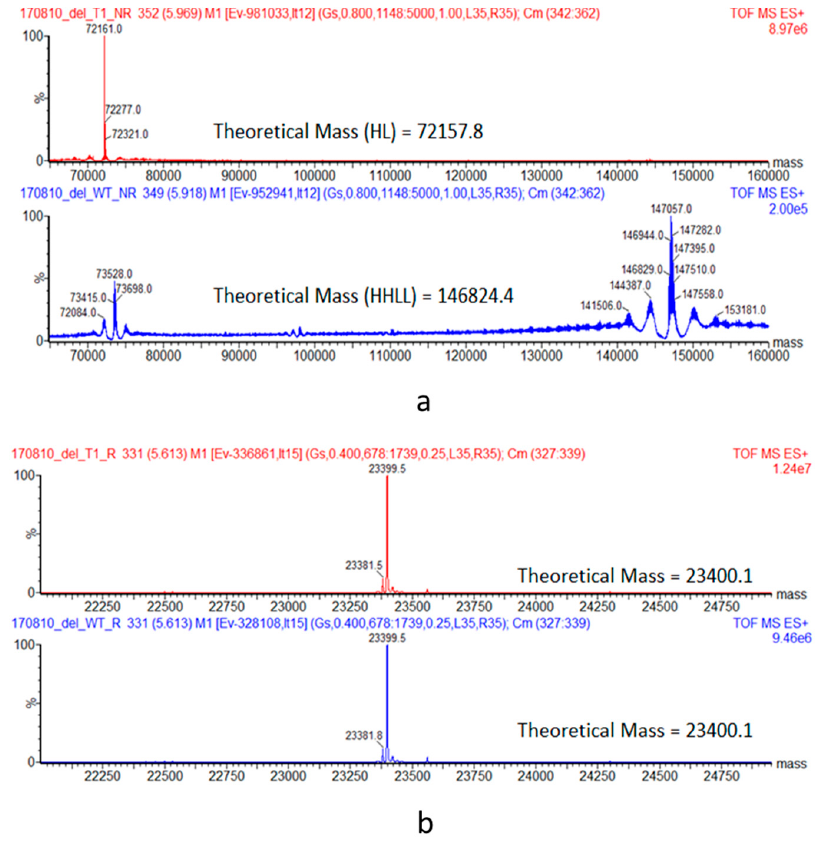
Figure 4. Analysis of the hinge deleted IgG4 and its corresponding full-length control mAb by LC–MS. ( a ) Deconvoluted spectrum of a nonreduced analysis. Under denaturating conditions, the hinge deleted IgG4 molecule has an apparent mass of 72,161.0 Da consistent with a Heavy-Light (HL) molecule with G0F N-Glycans. The full length mAb control has the expected mass of 146,829.0 Da consistent with the H2L2 structure (with G0F N-Glycans). Under reducing conditions, the heavy chain (Figure 3d) and Light chains ( b ) can be separated. The hinge deleted IgG4 and the full-length control molecule have the same light chain (23,399.5